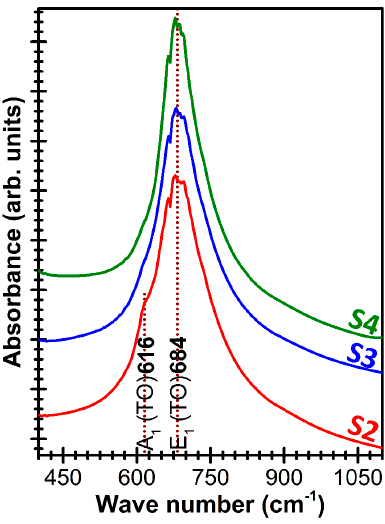
Figure 4. Comparative Fourier Transform Infrared (FTIR) spectra of ~1 μ m thick AlN films deposited starting from different base pressure levels.